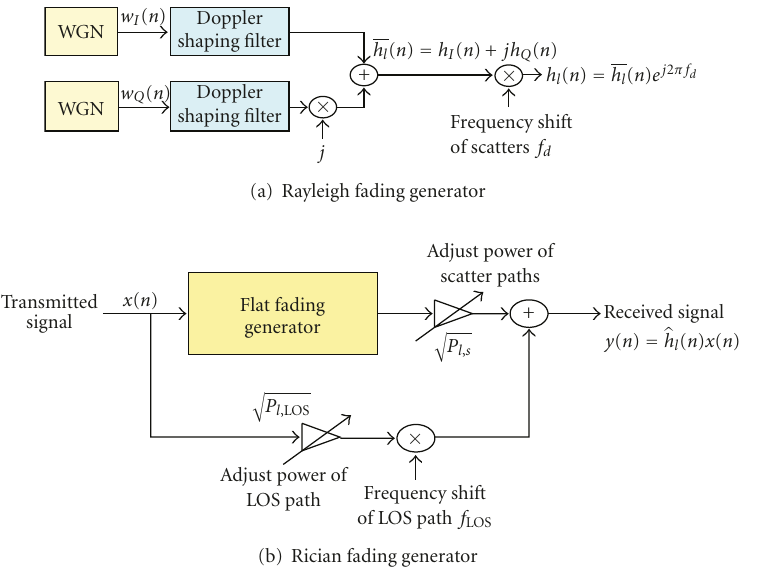
Figure 4: Rayleigh and Rician fading generators.